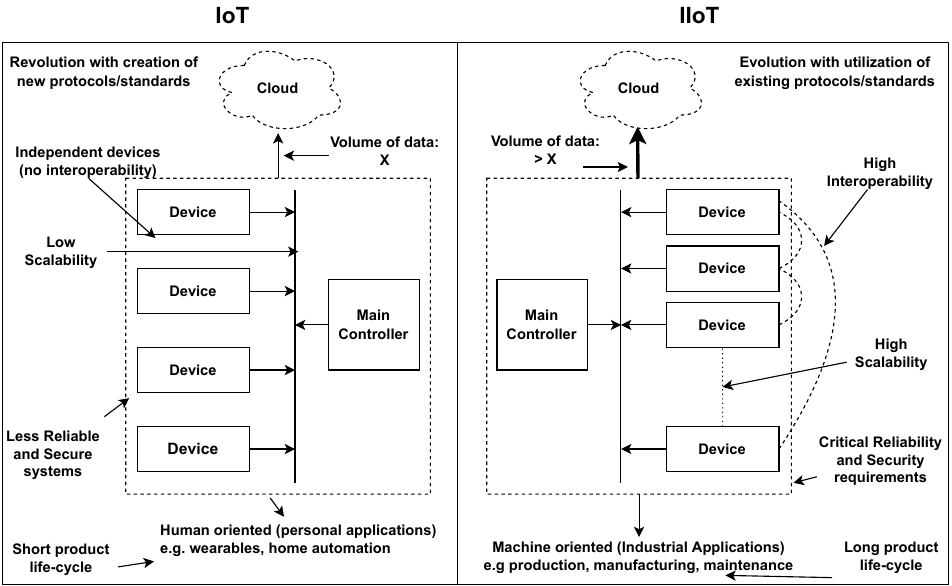
Figure 1. Main differences between IoT and IIoT